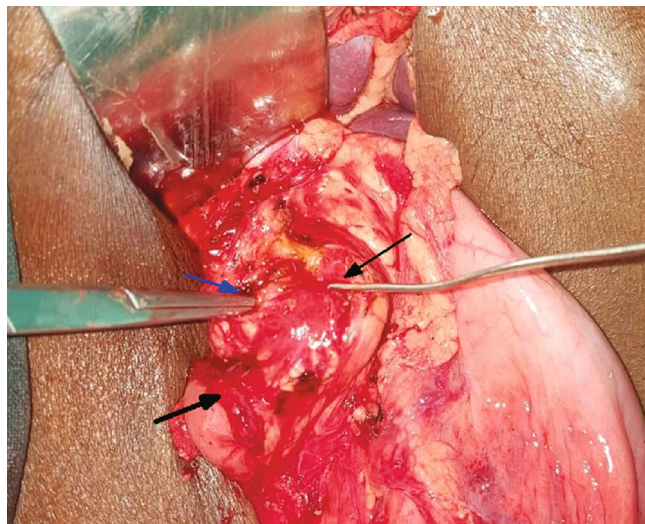
Figure 2: Intraoperative view showing combined bile duct ( probed and black arrow ) and pancreatic duct ( probed , blue arrow ) injuries. Note that the bile stained fi eld and the divided fi rst part of the duodenum ( black arrow